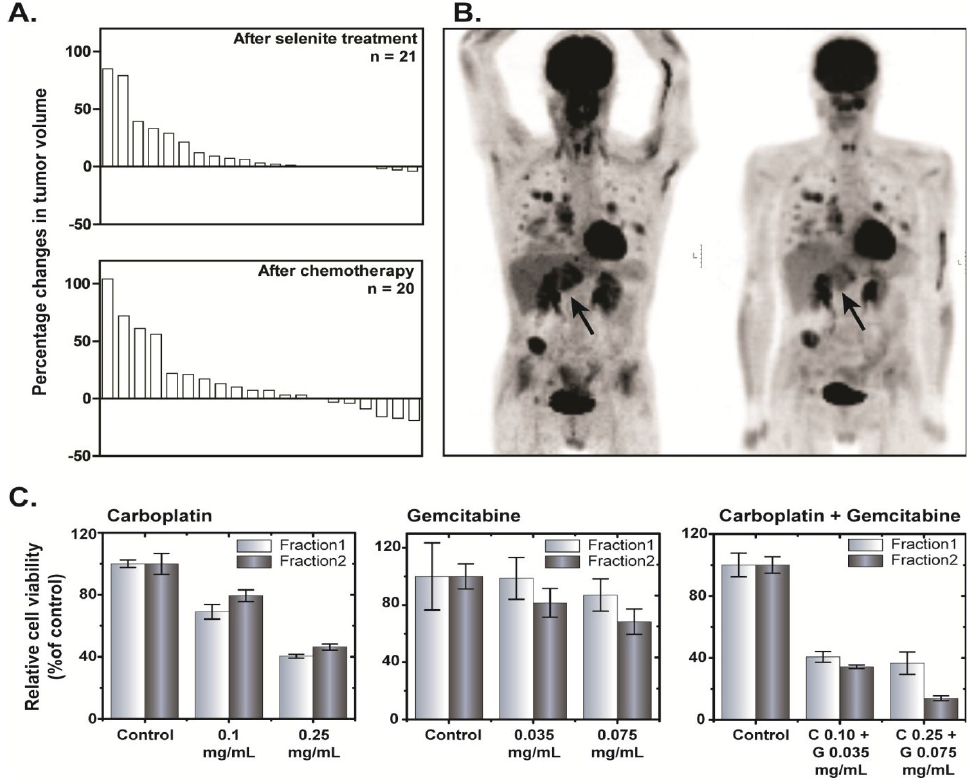
Figure 4. ( A ) Waterfall plot showing tumor response following selenite treatment (top panel) and subsequent administration of chemotherapeutic drugs (bottom panel). In the waterfall plot, a positive value indicates increase in tumor volume and vice versa . ( B ) Anterior-posterior Maximum Intensity Projection (MIP) PET images of a 48 year old man with multiple metastases from a carcinoma of the left sinus ethmoidalis, acquired 60 min after iv administration of [ 18 F]-2-fluoro-2-deoxy-D-glucose (FDG) (4 MBq/kg body weight); left panel, baseline examination; and right panel, examination after 17 days following stopping his selenite treatment (three treatments with 28.2 mg selenite a day). A few hours after the first treatment, his primary tumor, localized behind his left eye, started to swell, producing a massive increase of his earlier modest exophthalmos. However, it returned to the earlier status after 1–2 days. This examination shows a general decrease of the FDG-uptake of the metastases, most evident in a large metastasis of the left liver lobe (arrow). ( C ) Toxicity of single or combined exposure of carboplatin and gemcitabine for 48 h to cells collected from pleural exudates from a patient. Fraction 1 indicates before selenite treatment and Fraction 2 indicates after selenite treatment. Data are presented as mean ± S.D. 160 × 143 mm (300 × 300